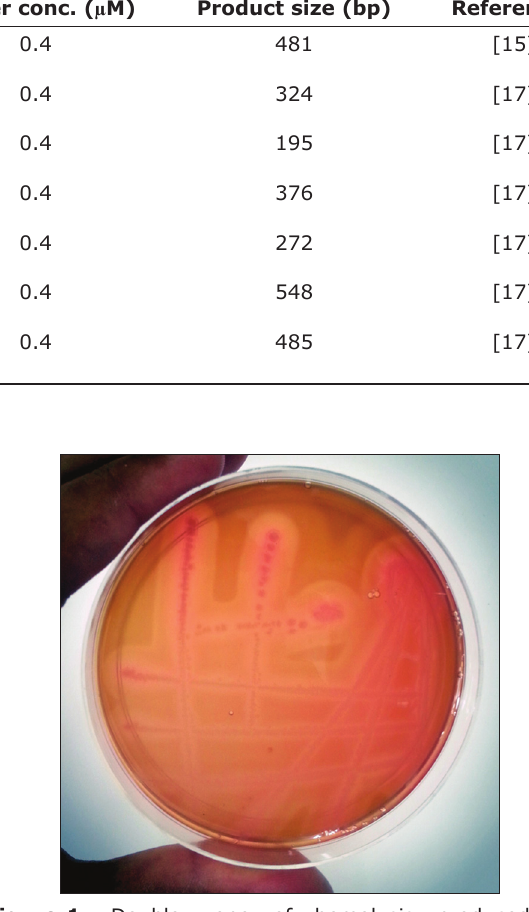
Figure-1: Double zone of hemolysis produced by Clostridium perfringens on sheep blood agar.